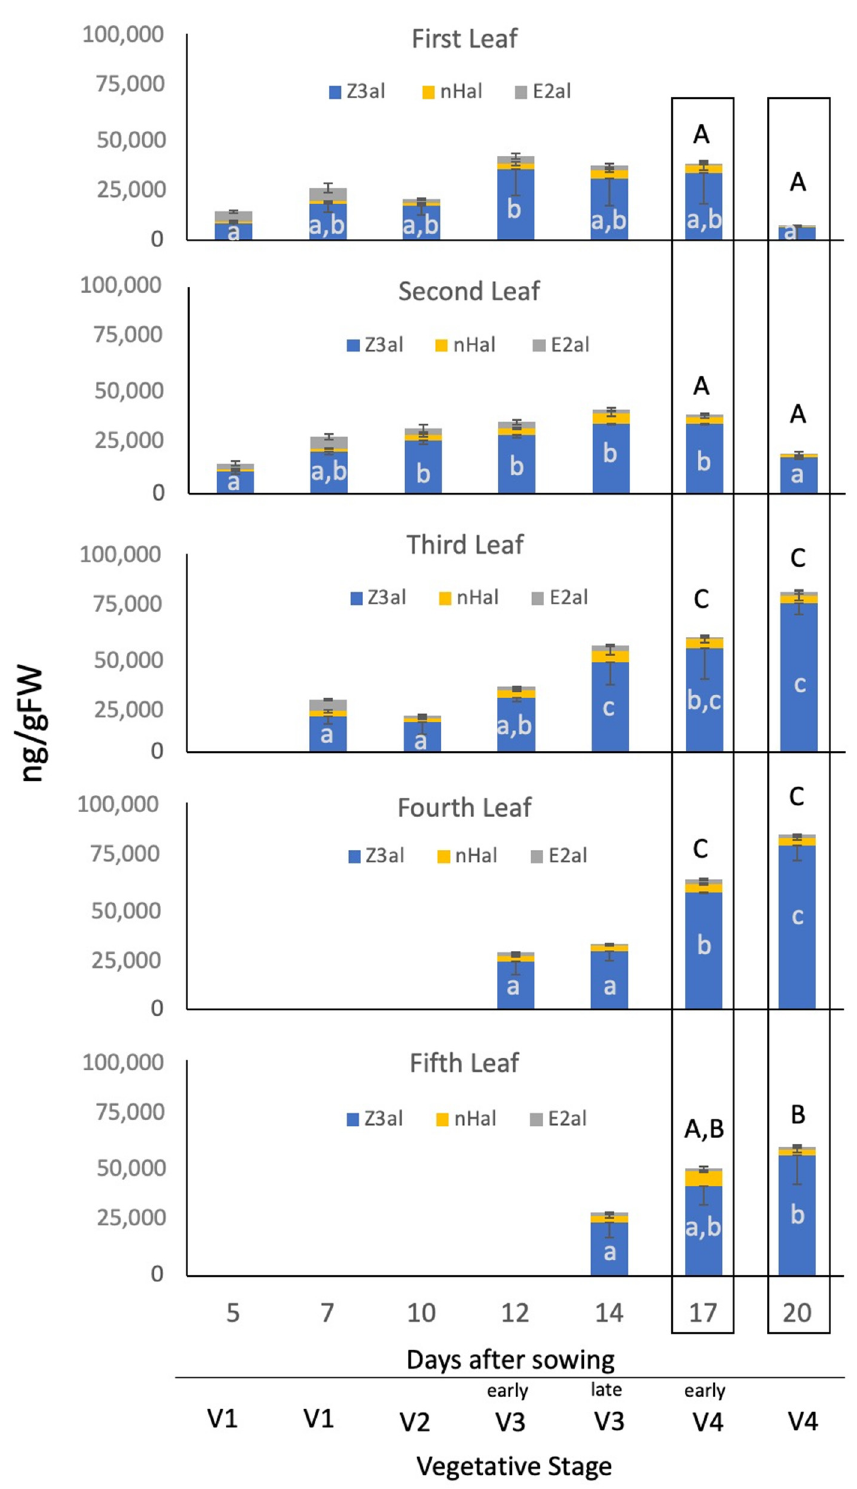
Figure 3. Capacity to produce aldehyde GLV at different developmental stages (V1–V4) in maize. Results for Z-3-hexenal (Z3al), n-hexanal (nHal), and E-2-hexenal (E2al) at different ages and their corresponding developmental vegetative stage are shown. The values are means ± SD, and the different letters indicate significant differences (ANOVA, p ≤ 0.05) in the total amount of aldehyde GLV. White letters inside the bars indicate differences within one leaf during development, while black letters above bars indicate differences between leaves (only for day 17 and 20 after sowing, marked by the framed boxes).